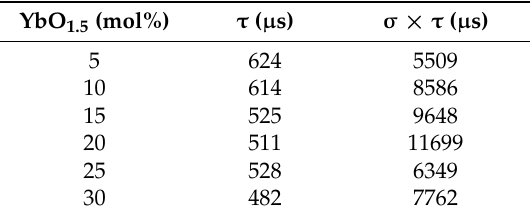
Table 2. Lifetime, τ and σ × τ values for Yb-doped aluminosilicate